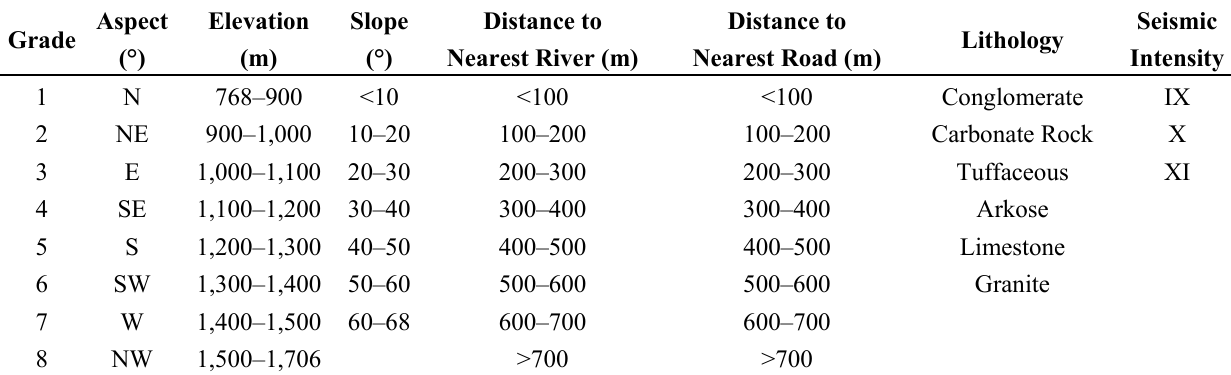
Table 3. Detailed grades of the control factors used for correlation